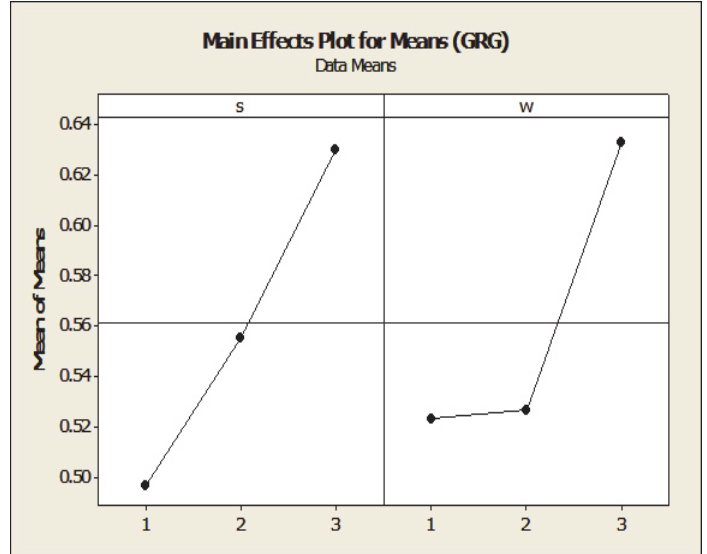
Fig. 9. Main effects plot for means of grey relational